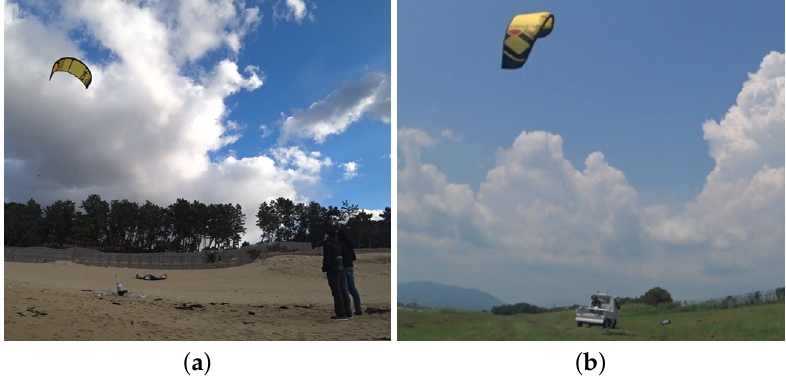
Figure 3. Flight tests with ( a ) stationary kite control unit (KCU) anchored at the ground and ( b ) towed KCU flying on a short